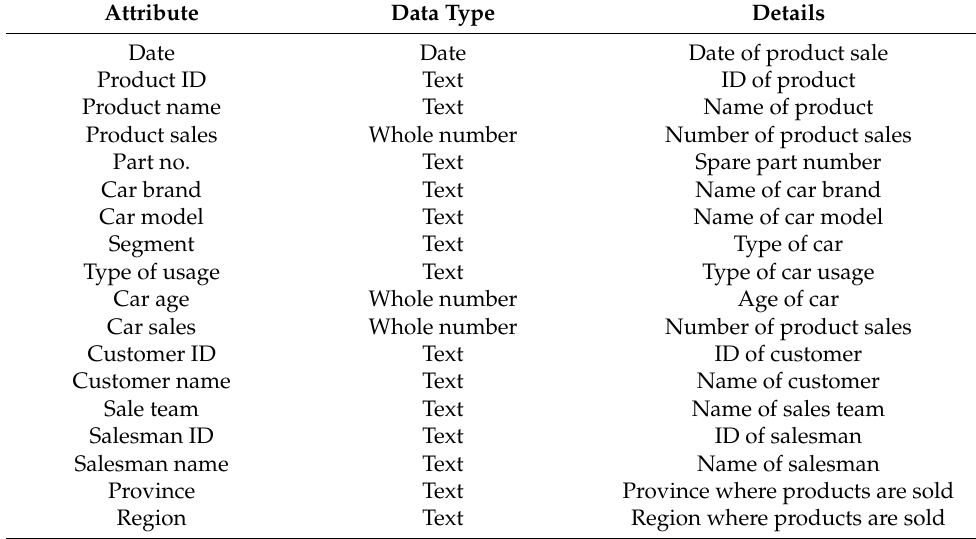
Table 1. Internal data from the case study